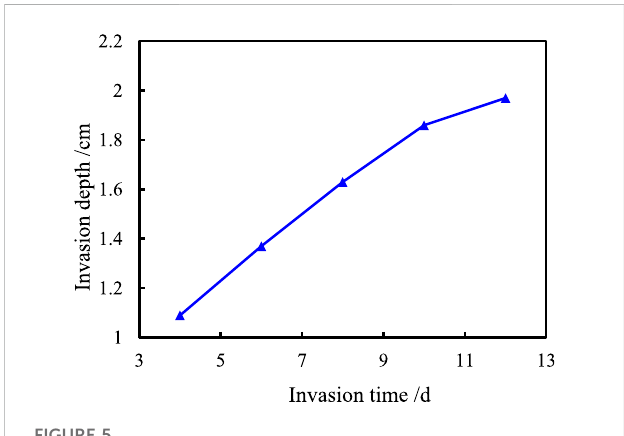
FIGURE 6 Variation of drilling fl uid invasion depth with con fi ning